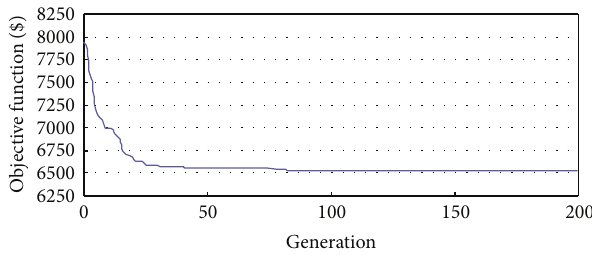
Figure 4: Convergence efficiency of GA under M-to-M.